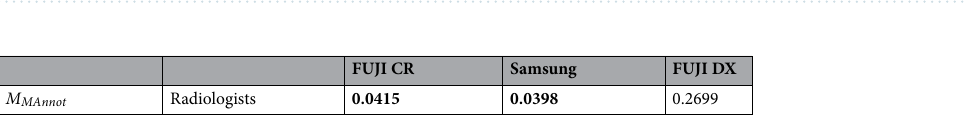
Table 10. Statistical significance of differences in ROC between M MAnnot and radiologists for each CXR equipment on CHVNGE according to the De Long test. Bold indicates p < 0.05